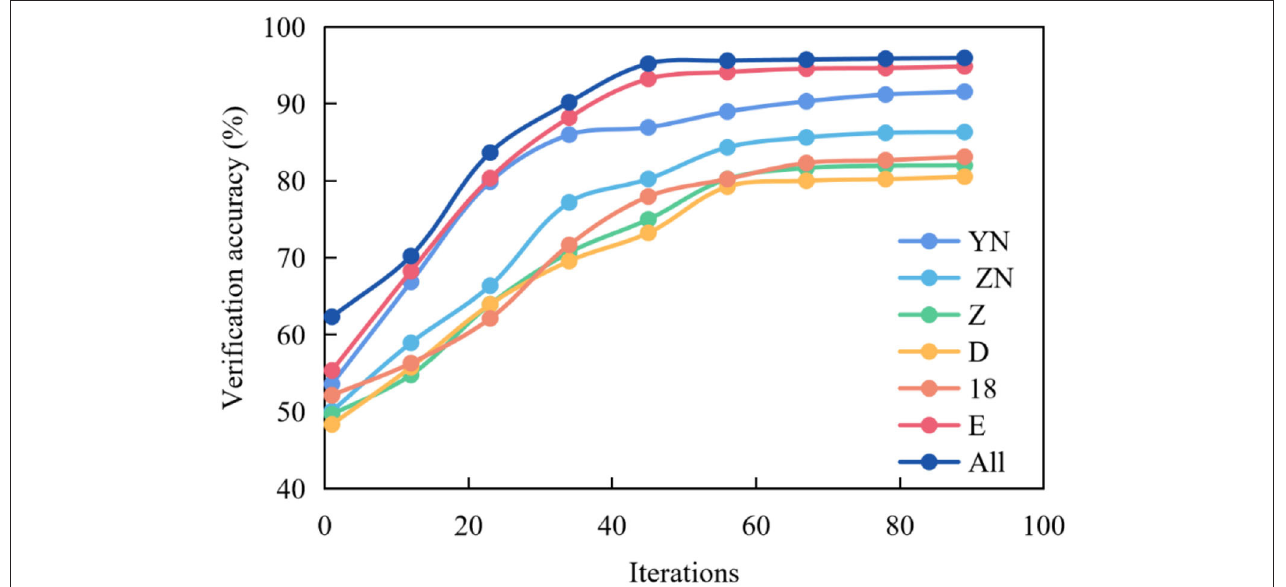
FIGURE 4 | Average verification accuracy curve of multispectral image fusion in multiple brain regions.